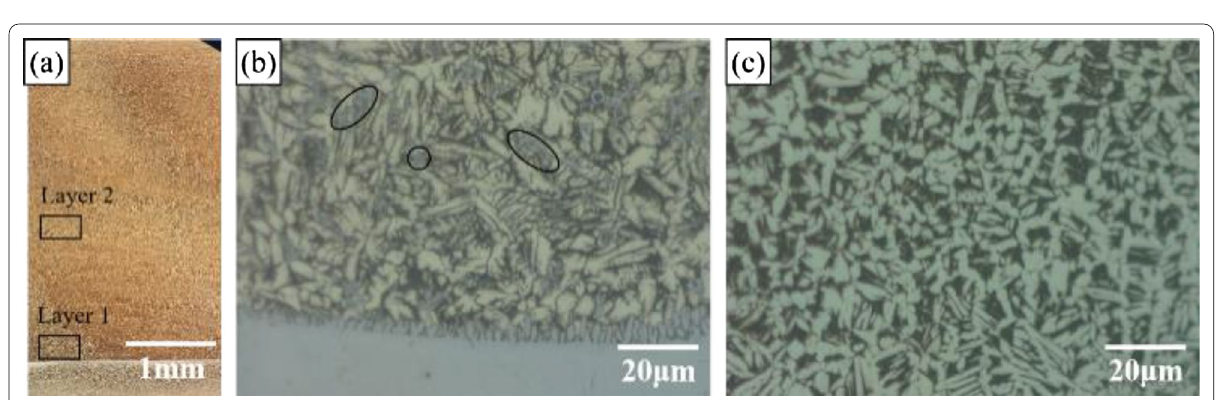
Figure 13 OM images of S5 section: a multi-layers; b layer 1; c layer